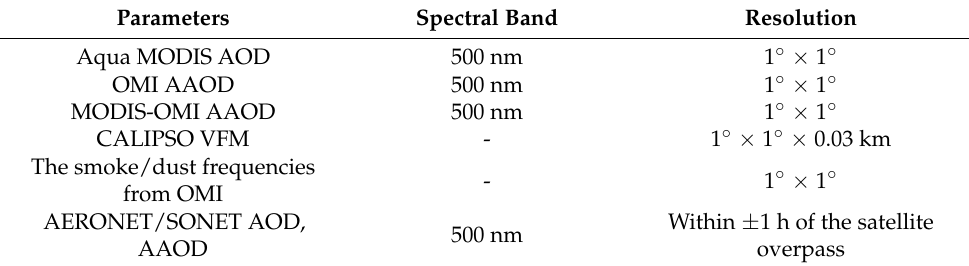
Table 1. The parameters used in this study.